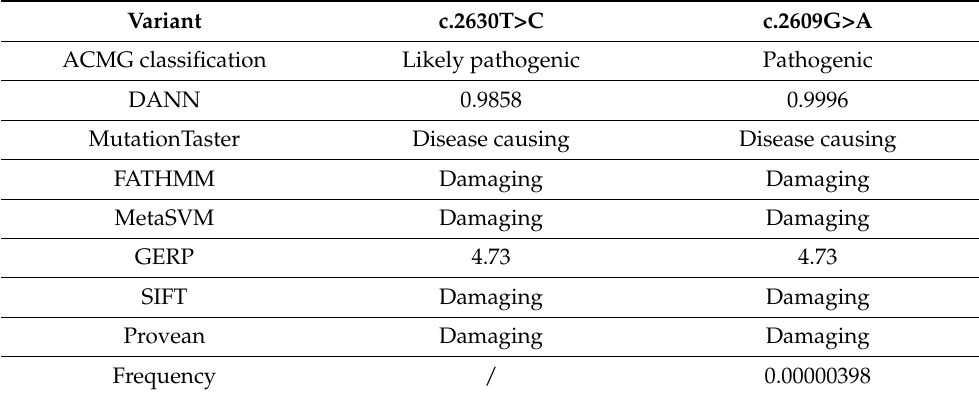
Figure 3. ( A ) MYH7 domain; ( B ) identification of variant M877T in MYH7 ; ( C ) identification of variant R870H in MYH7 . The arrows indicate the position of the variants identified in heterozygosity. Table 2. Prediction data for variant c.2630T>C e c.2609G>A in MYH7